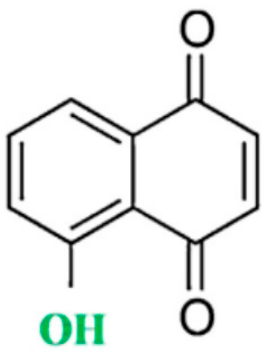
Figure 1. Chemical structure of juglone.